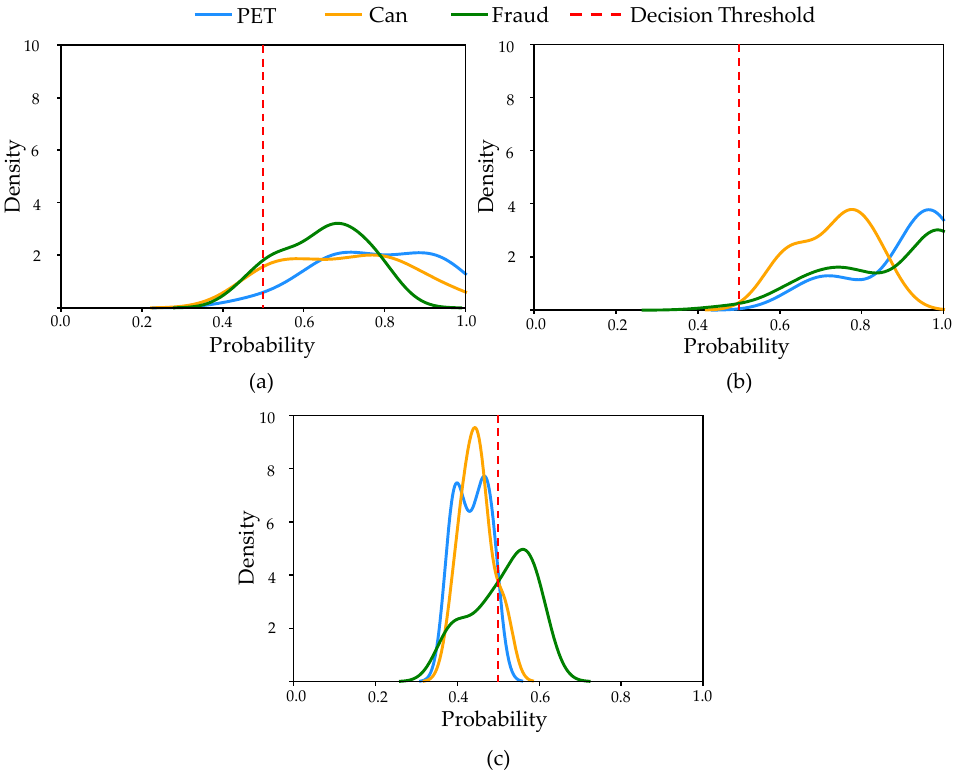
Figure 11. Kernel density estimation for prediction result of fraud objects: ( a ) MobileNetV2 trained only with top view images; ( b ) MobileNetV2 trained only with front view images; ( c ) The proposed CNN ensemble